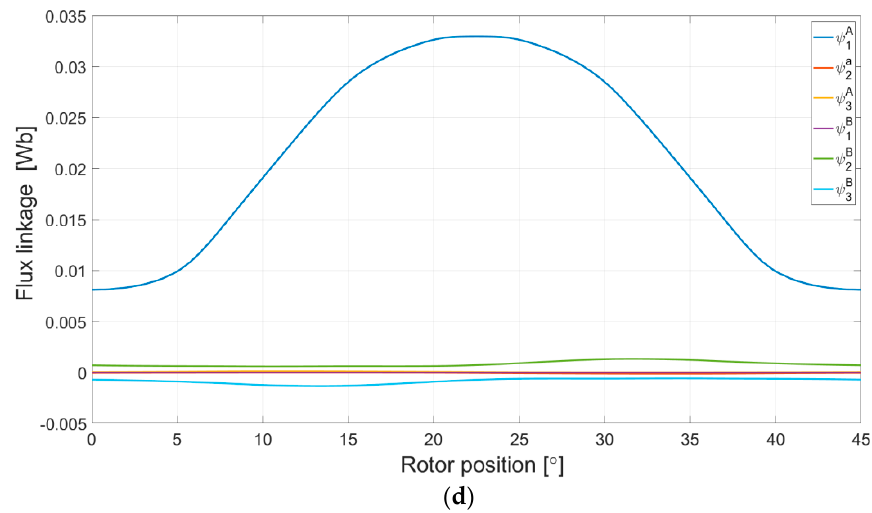
Figure 5 . Static torque and flux linkage characteristics of the DCSRM. (a) Electromagnetic torque T e vs. rotor position θ in DCO mode ( i A = i B = 0.7 I ref ) and SCO mode ( i A = I ref , i B = 0)—simulation. (b) Electromagnetic torque T e vs. rotor position θ in DCO mode ( i A = i B = 0.35 I ref ), channel A SCO mode ( i A = 0.5 I ref , i B = 0), and channel B SCO mode ( i A = 0, i B = 0.5 I ref )—laboratory test. (c) Flux linkage vs. rotor position θ in DCO mode ( i A = i B = 0.7 I ref )—simulation. (d) Flux linkage vs. rotor position θ in SCO mode ( i A = I ref , i B = 0)—simulation.